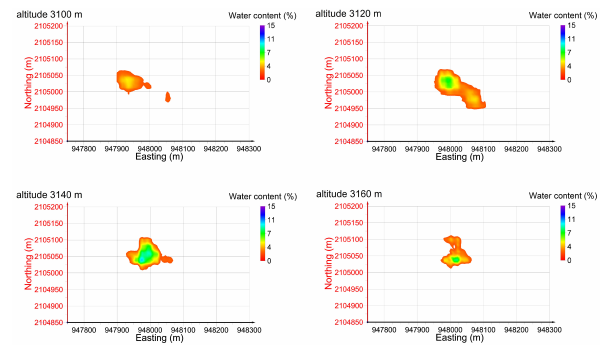
Fig. 9. 3-D-SNMR image of the water-filled cavern observed in September 2011 and shown as slices at different altitudes.